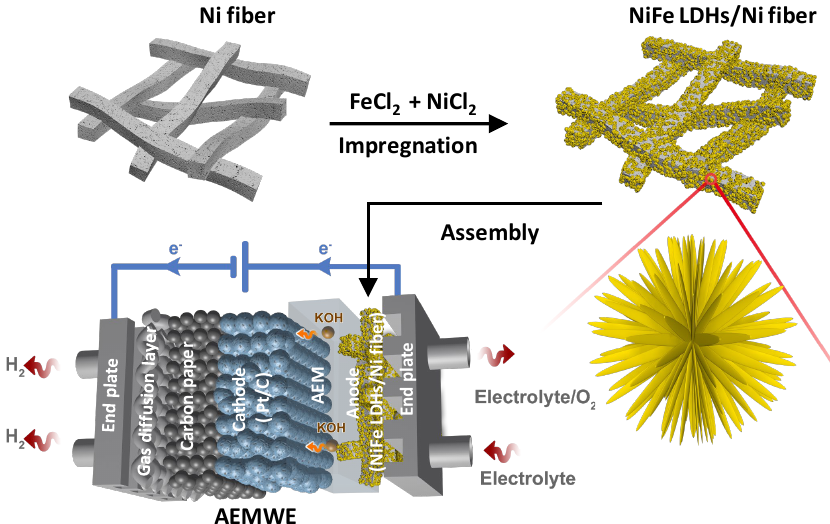
Figure 1. Schematic preparation of NiFe LDHs/Ni fiber electrode and as the anode of the AEMWE.